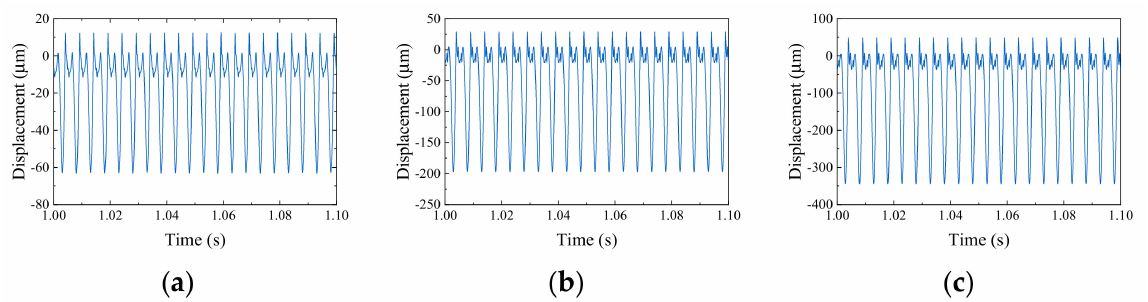
Figure 7. Imbalance and rubbing coupling faults: ( a ) value of imbalance 20 × 10 − 5 kg · m; ( b ) value of